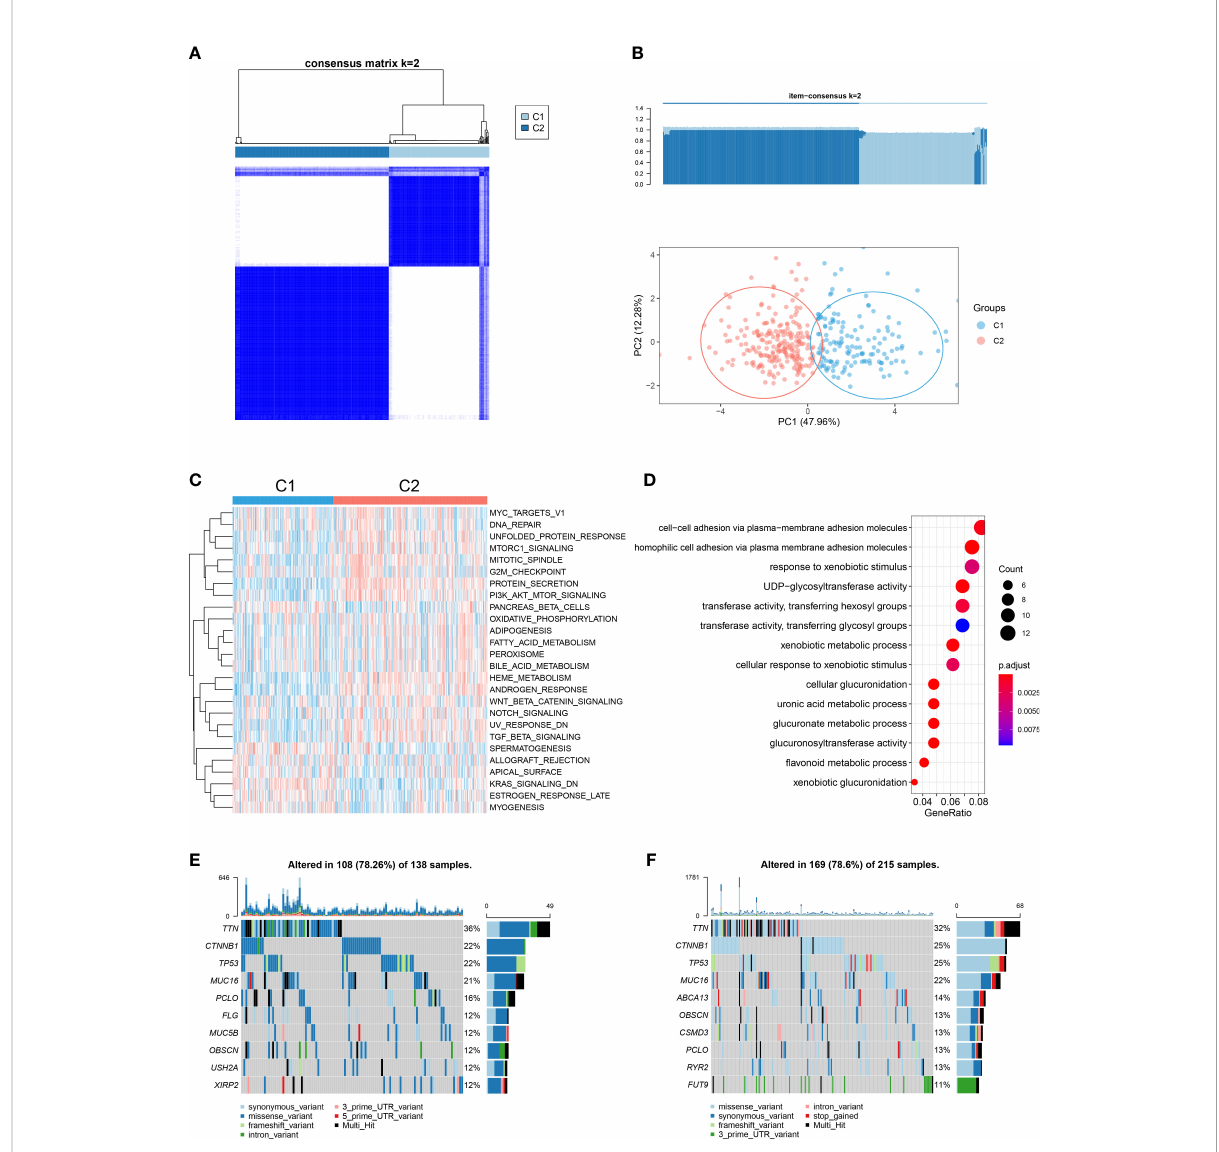
FIGURE 4 Cuproptosis patterns in the TCGA-LIHC cohort and relevant biological pathways. (A) Similarity matrix of TCGA-LIHC patients derived from consensus clustering assays. (B) Principal component analysis results for the two distinct patterns in the TCGA-LIHC cohort. (C) GSVA scores of representative Hallmark pathways in cuproptosis-C1 and cuproptosis-C2 patterns as shown in the heatmap. (D) Dotplot showing GO term enrichment analysis of DEGs between patterns. (E) Of the 138 patients in cuproptosis-C1, 108 (78.26%) showed gene mutations. The right bar plot shows the mutation frequency of each gene and each column represents an individual patient. (F) Of the 215 patients in cuproptosis-C2, 169 (78. 6%) showed gene